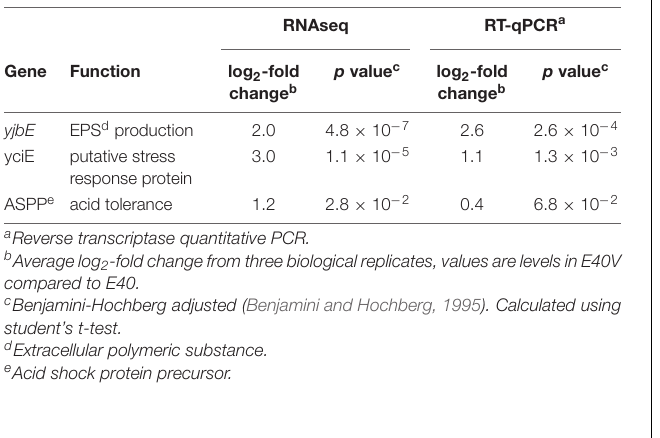
TABLE 4 | Strain E40V genes with greater steady state levels of mRNA than strain E40.